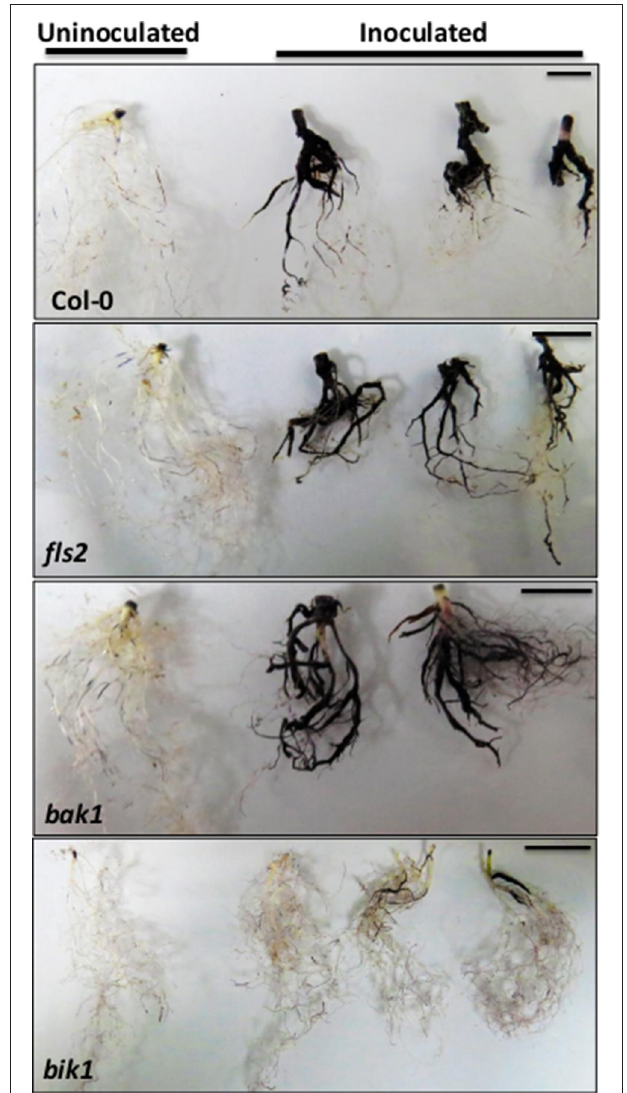
FIGURE 4 | Analysis of ROS production. Visualization of O − 2 production in representative NBT-stained control, and fls2, bak1 and bik1 mutant roots at 21 days post inoculation with P. brassicae. Dense blue forazan precipitates were observed at the site of H 2 O 2 production. Bar =